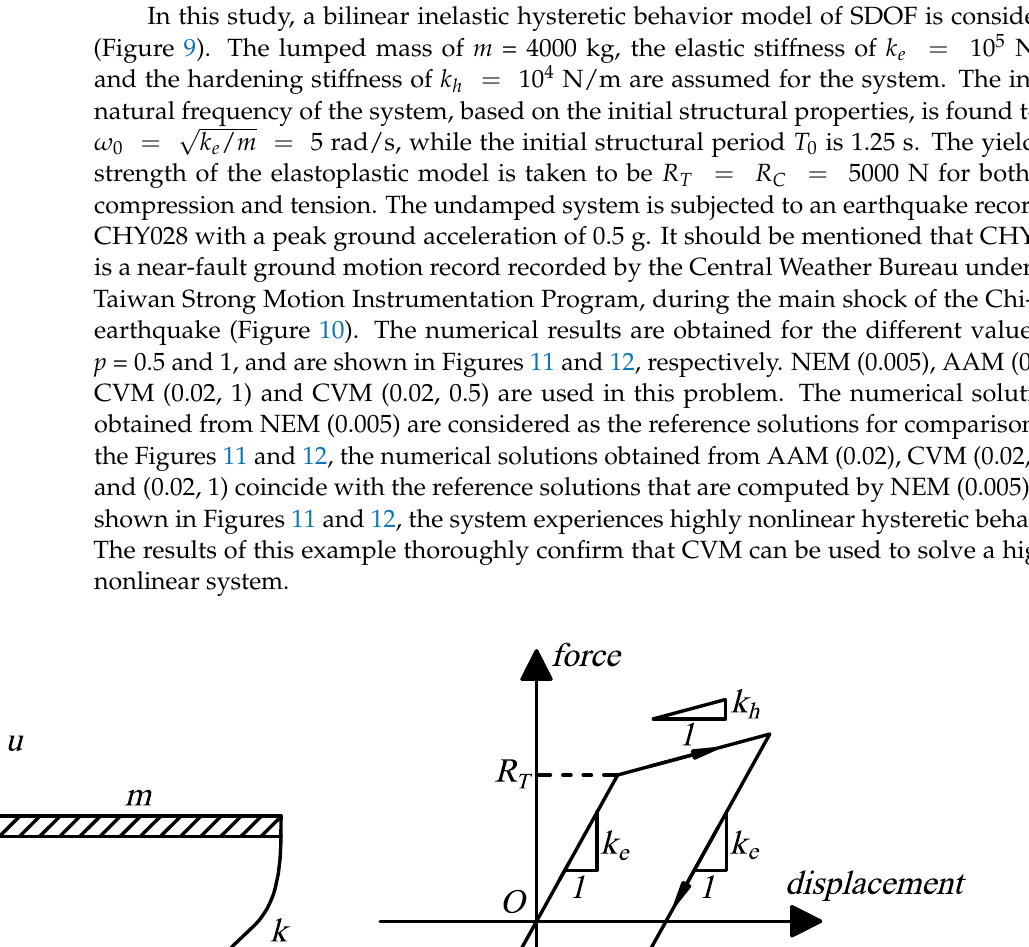
Figure 10. The ground acceleration record of CHY028.